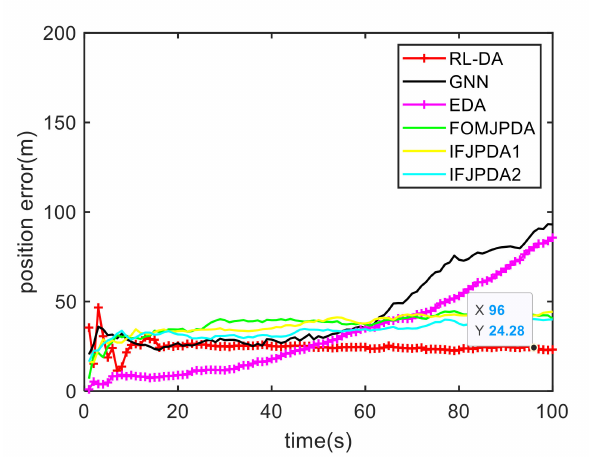
Figure 10. Comparison of the position errors for Target 1 in Case